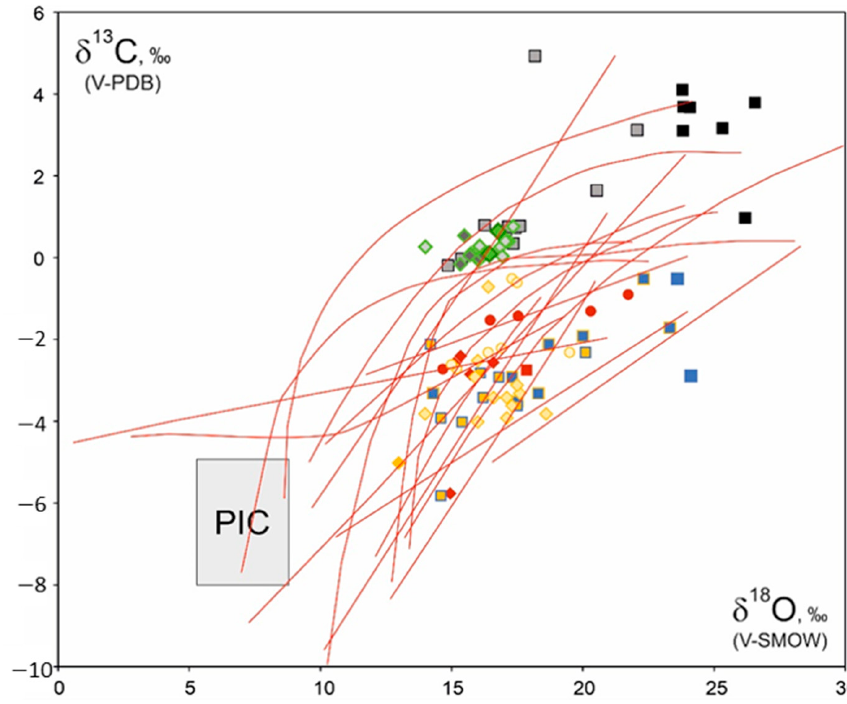
Figure 7. Isotope ( δ 18 O and δ 13 C) composition of carbonates of the studied rocks. Red solid lines show the isotope composition of the host carbonate rocks from outer contact zones of intrusions from different locations in the world (drawing using compilation [41]). PIC—primary igneous carbonatites—the compositional field of primary magmatogenic carbonatites [42]. The symbols are the same as in Figure 6.